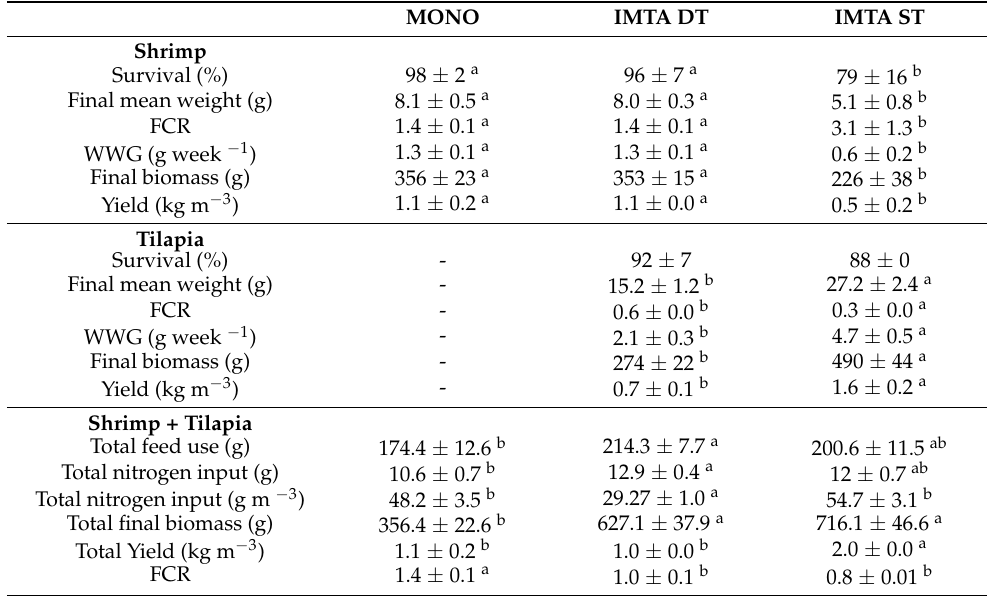
Table 2. Zootechnical performance (mean ± standard deviation) of L. vannamei and O. niloticus during the experiment in the different treatments: MONO (shrimp monoculture), IMTA DT (integrated tilapia and shrimp in the same tank), and IMTA DT (integrated culture tilapia and shrimp in different